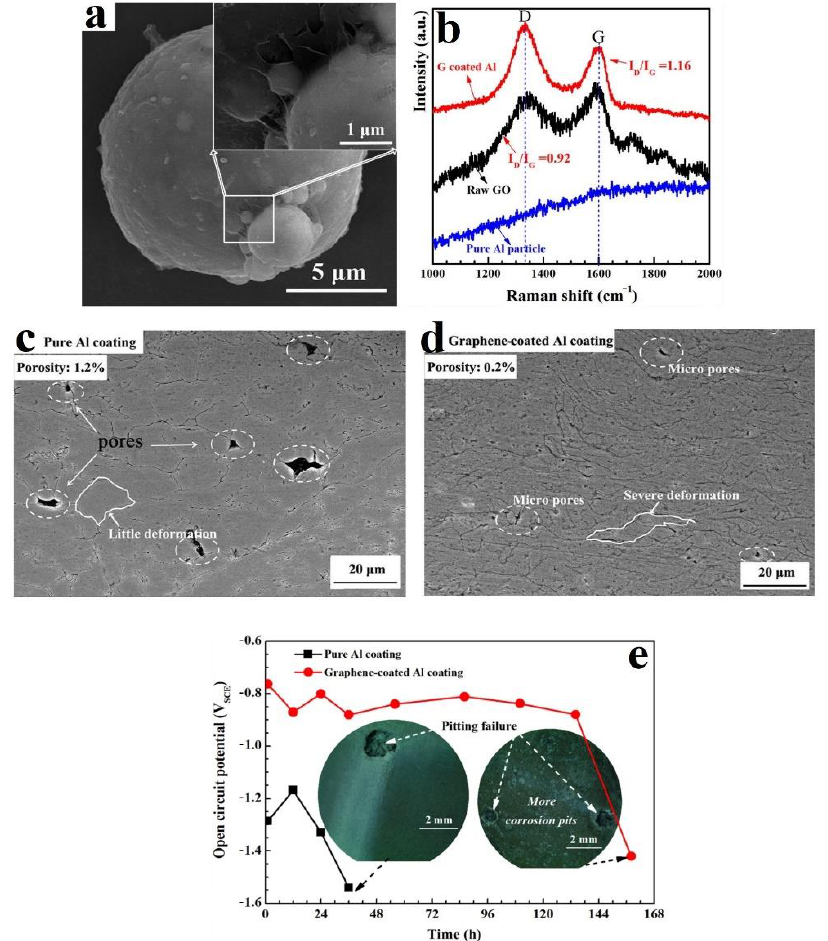
Figure 6. ( a ) SEM image of GNP/Al powder (0.75 wt% GNP), ( b ) Raman spectra of pure Al, raw GO, and RGO/Al powder, ( c ) SEM image of CS pure Al coating, ( d ) SEM image of CS GNP/Al composite coating, ( e ) corrosion behaviour (open-circuit potential) and images of corroded pure Al and GNP/Al composite coatings. Presented with permission from [68].